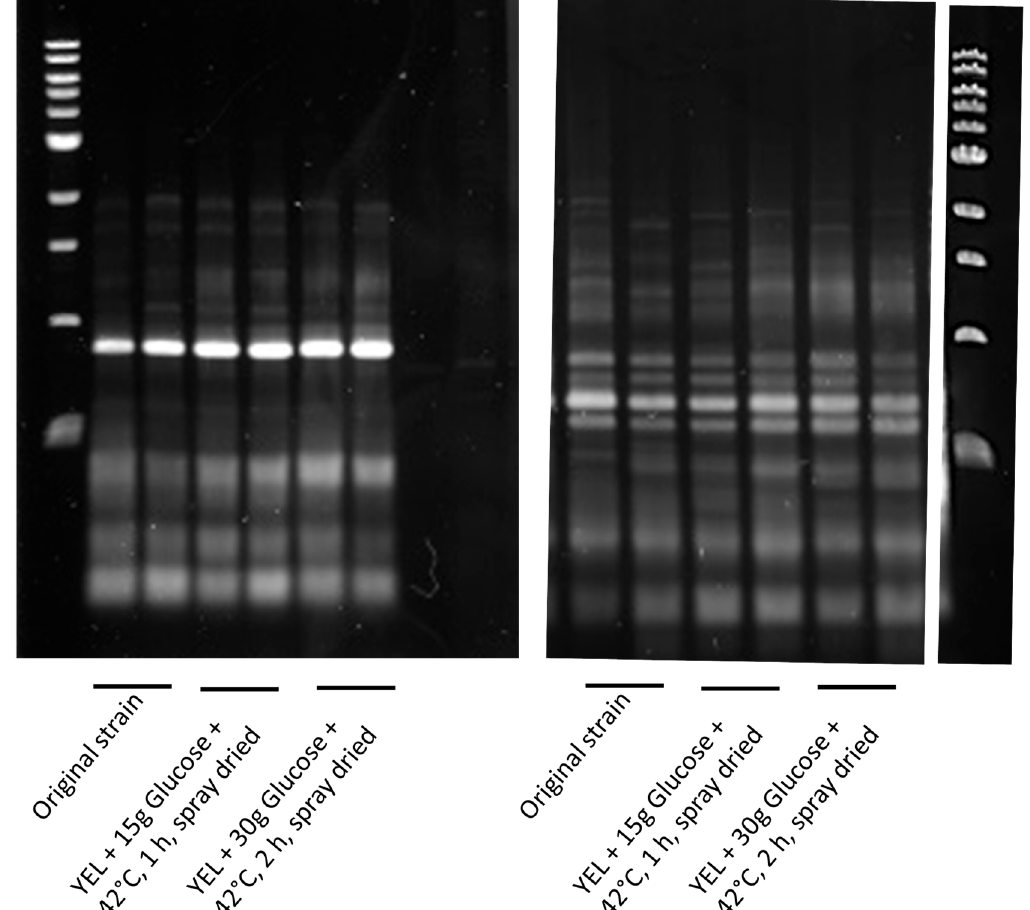
Figure 3. RAPD analysis of P. freudenreichii cultures before and after adaptation and drying P. freudenreichii . Colonies were isolated from the original culture and from powders after adaptation and spray drying. RAPD was performed using two RAPD primers (left: primer 1: AAGAGCCCGT and right: primer 2: AACGCGCAAC) as described in “Materials and Methods”. Amplified products were resolved by electrophoresis (100 V, 1 h) on 1% agarose gels. First and last lines correspond to 1 kb DNA ladder.